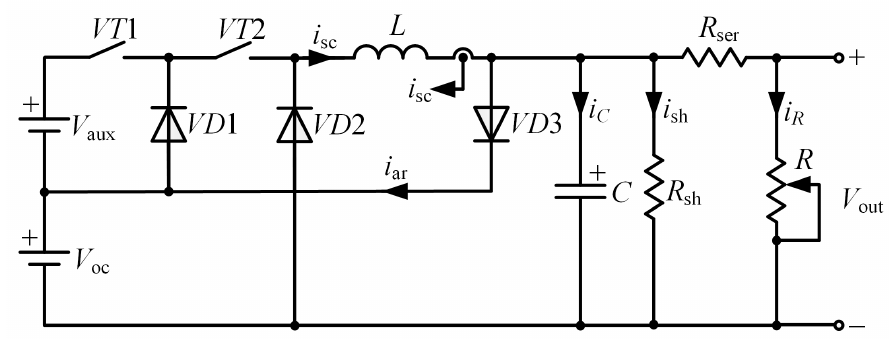
Figure 4. Solar panel simulator topology.